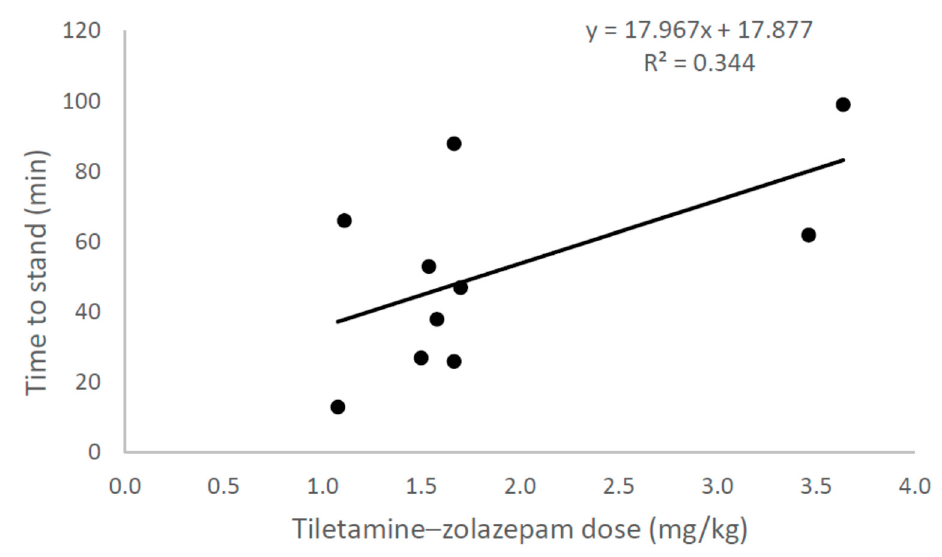
Figure 4. Ten ground-netted Bennett’s wallabies ( Notamacropus rufogriseus ) were lightly sedated using tiletamine–zolazepam (500 mg powder; Zoletil ® ; Virbac, NSW, Australia) using variable doses not